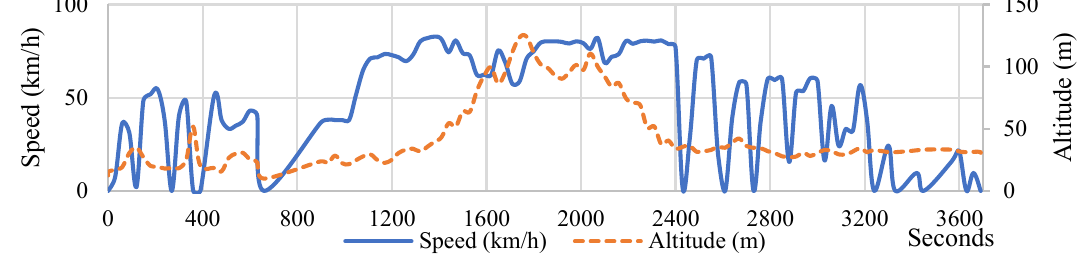
Figure 4. Drive cycle 3: GCM of 55,000 kg.